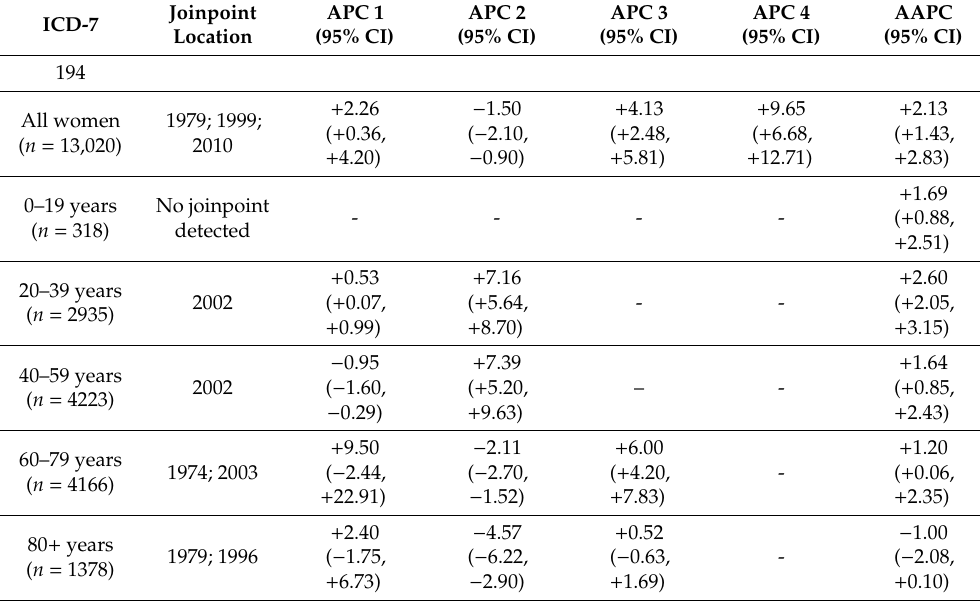
Table 1. Joinpoint regression analysis of thyroid cancer incidence in women in the Swedish Cancer Register 1970–2017. ICD-7 code 194 (https: // sdb.socialstyrelsen.se / if_can / val.aspx). APC = Annual Percentage Change (APC 1 = time from 1970 to first joinpoint; APC 2 = time from first joinpoint to 2017 or to second joinpoint; APC 3 = time from second joinpoint to 2017 or to third joinpoint; APC 4 = time